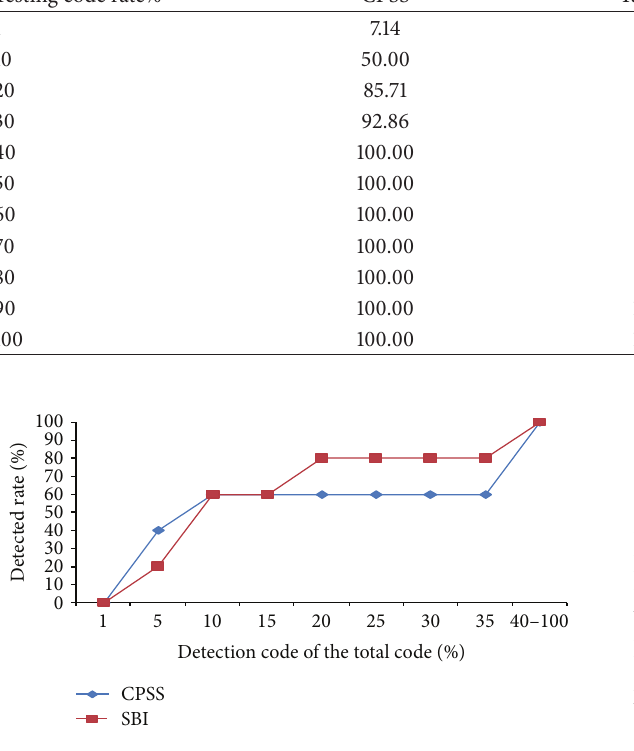
Figure 8: Location effect of the function